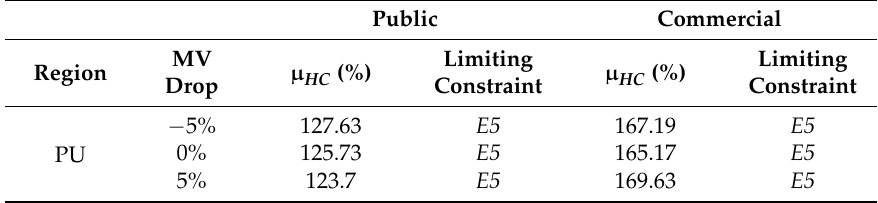
Table 7. Test Networks’ (public and commercial) mean HCs and their limiting constraints.